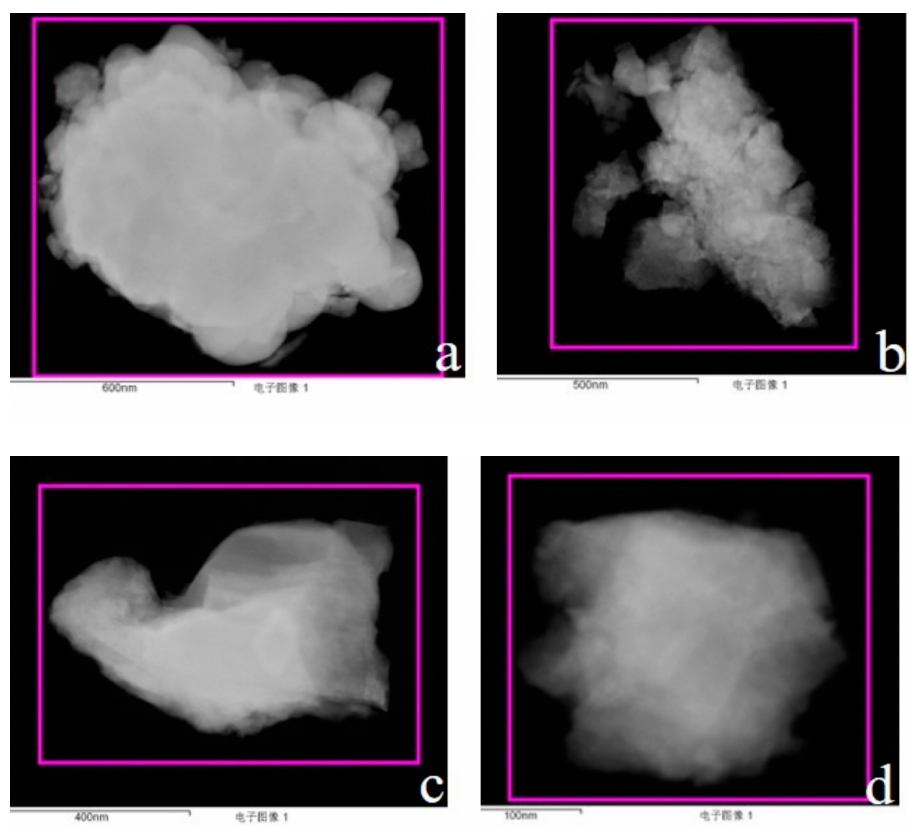
Figure 5. TEM Images of Ce aerosol particles. ( a ): Electronic image of cerium aerosol particles at 600 nm. ( b ): Electronic image of cerium aerosol particles at 500 nm. ( c ): Electronic image of cerium aerosol particles at 400 nm. ( d ): Electronic image of cerium aerosol particles at 100 nm. Table 7. Results of Semiquantitative analysis.